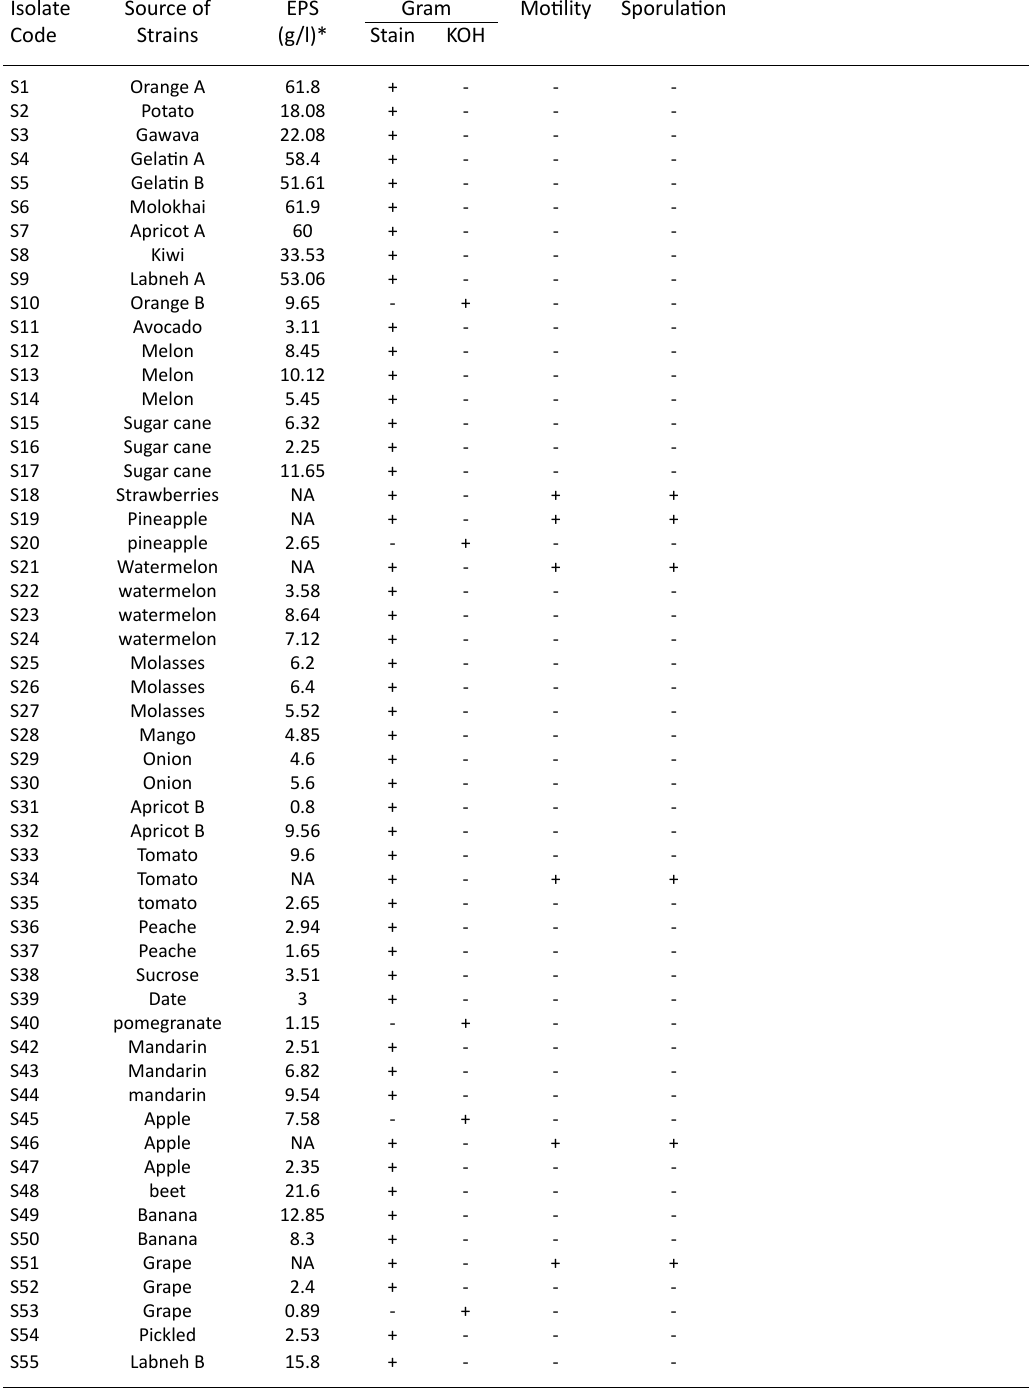
Table 1. Partial characterization of EPS producing isolates isolated from different sources Isolate Source of EPS Gram Motility Sporulation Code Strains (g/l)* Stain KOH S1 Orange A 61.8 + - - - S2 Potato + - - S3